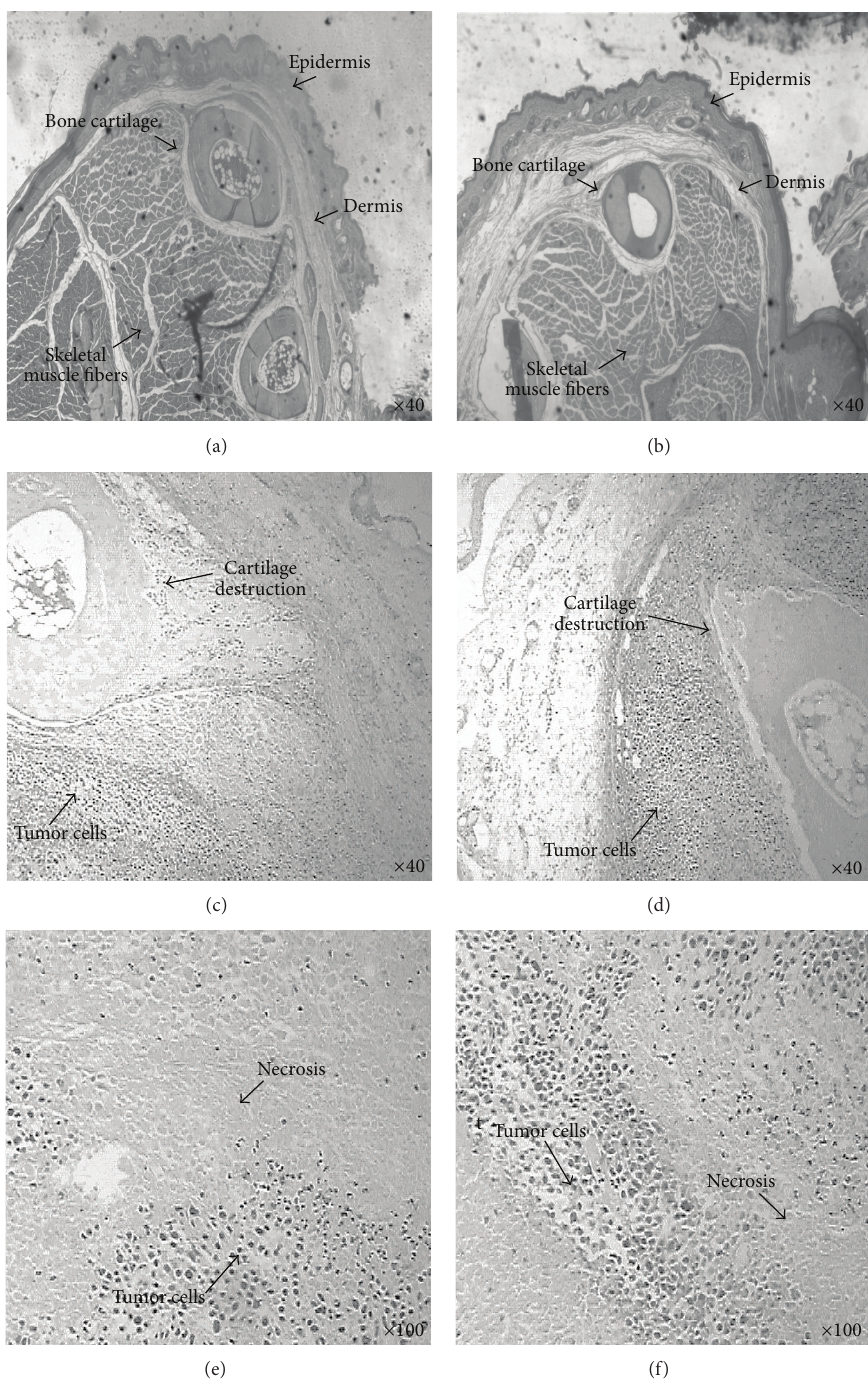
Figure 3: Quercetin does not alter Ehrlich tumor-induced histological modifications. Mice received saline (25 𝜇 L) or Ehrlich tumor cells (1 × 10 6 /25 𝜇 L) and were treated i.p. with quercetin (100mg/kg, 2% DMSO diluted in saline) or vehicle (2% DMSO) 10min after the i.pl. injection. The treatment continued daily during 12 days. In the 12th day, mice were euthanized and the paw was collected for histological analysis performed with hematoxylin/eosin staining. Panel (a) shows the histology of saline i.pl. plus quercetin vehicle group, (b) saline i.pl. plus quercetin (100mg/kg i.p.), (c and e) tumor animal treated with vehicle, and (d and f) tumor animal treated with quercetin (100mg/kg i.p.). Arrows indicate intact bone cartilage, presence of skeletal muscle fibers, dermis and epidermis: (a-b) bone/cartilage destruction (c-d), tissue necrosis (e-f), and presence of tumor cells